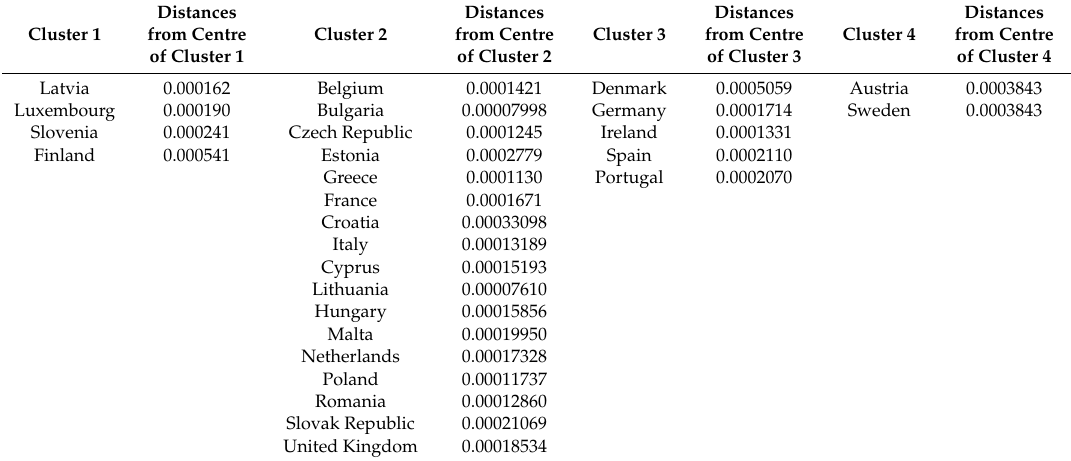
Table 20. Elements of clusters with distances from centers (own